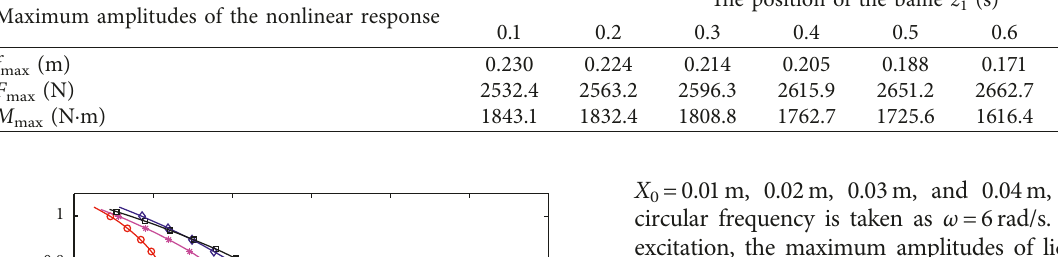
Table 1: The maximum amplitudes of the nonlinear response versus the position of the baffle for r Maximum amplitudes of the nonlinear response